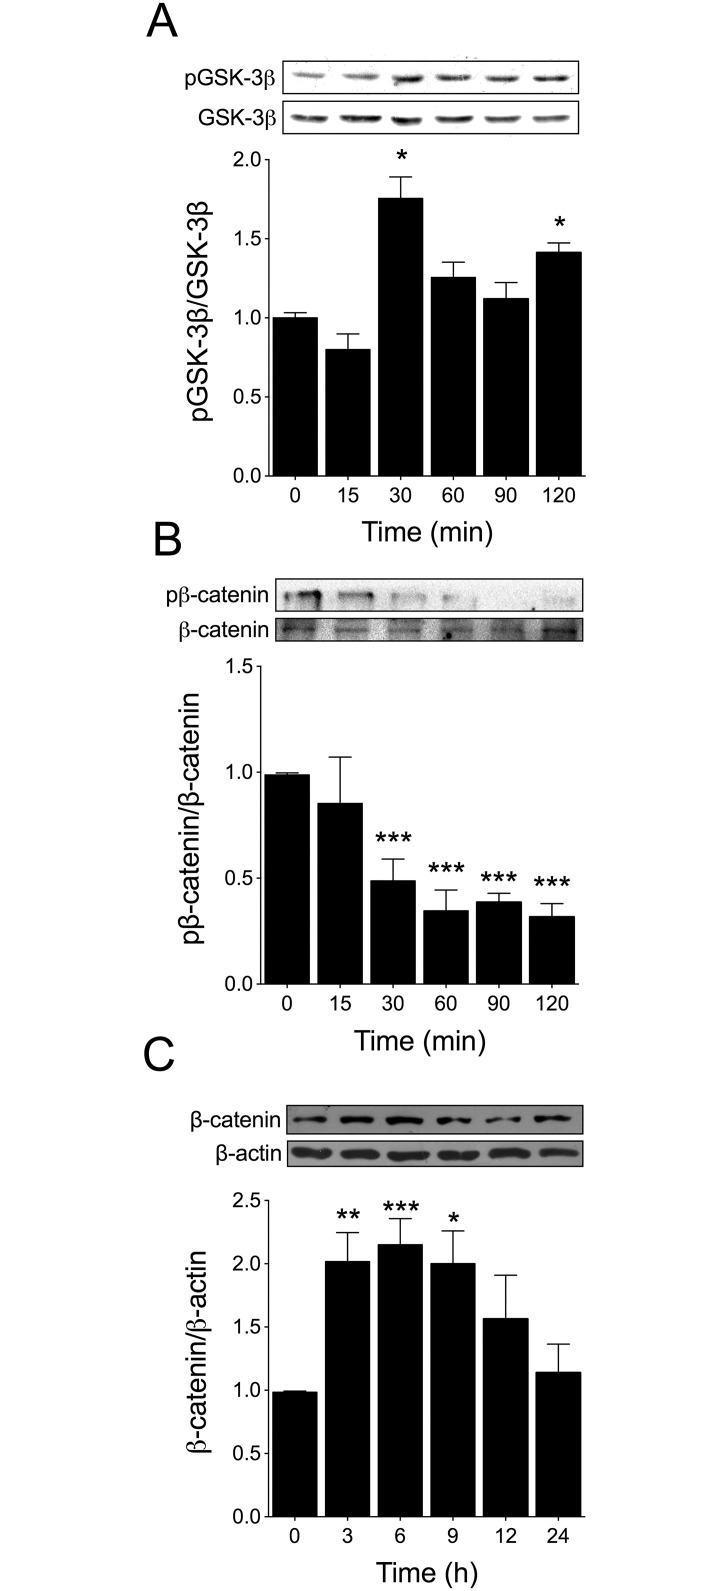
Testosterone inhibits GSK-3β in cardiac myocytes.Cardiac myocytes were stimulated with 100 nM testosterone for 15, 30, 60, 90, and 120 min and subjected to Western blot analysis to determine (A) GSK-3β phosphorylation (p-GSK-3β, Ser9) and protein levels (n = 5) and (B) β-catenin phosphorylation and total β-catenin protein levels (n = 4). The densitometric analyses show the ratio of phosphorylated versus total protein. Testosterone increased GSK-3β phosphorylation at Ser9 and decreased β-catenin phosphorylation at Ser33, Ser37, and Thr41 after 30 min of stimulation. (C) Cardiac myocytes were stimulated with 100 nM testosterone for 3, 6, 9, 12, and 24 h and total β-catenin protein accumulation was determined through Western blotting (n = 5). Values are presented as the mean ± SEM. *p < 0.05, **p < 0.01, and ***p < 0.001 vs. control non-stimulated condition.